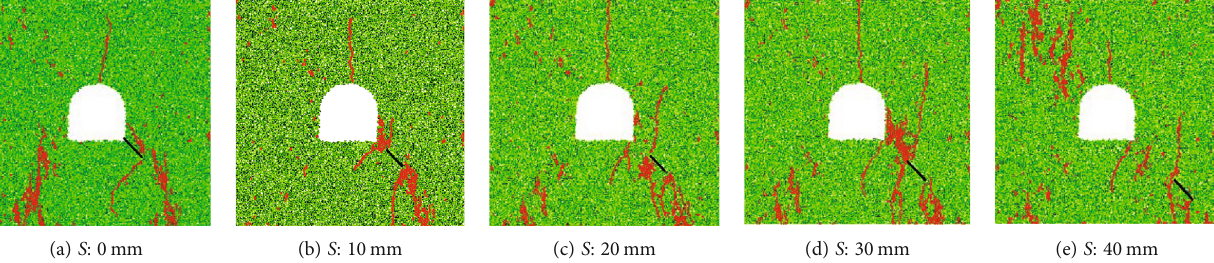
Figure 12: Failure characteristics of the tunnel with di ff erent borehole spacing.